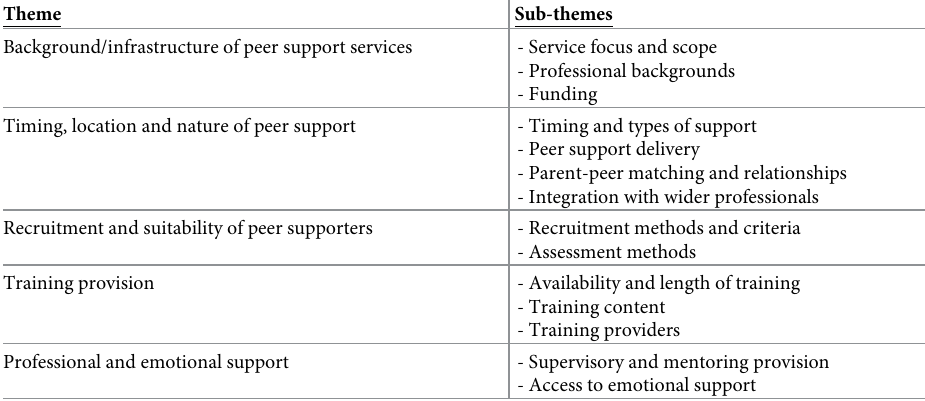
Table 3. Overview of themes and